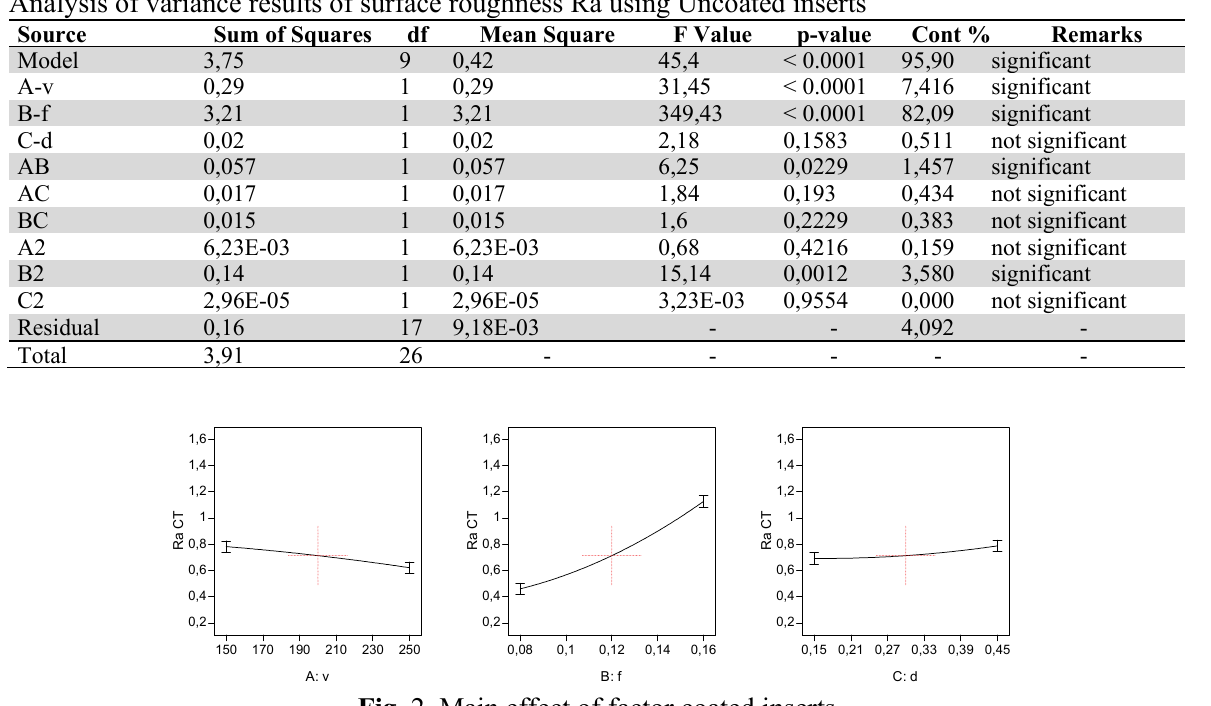
Analysis of variance results of surface roughness Ra using Uncoated inserts Source Sum of Squares Model